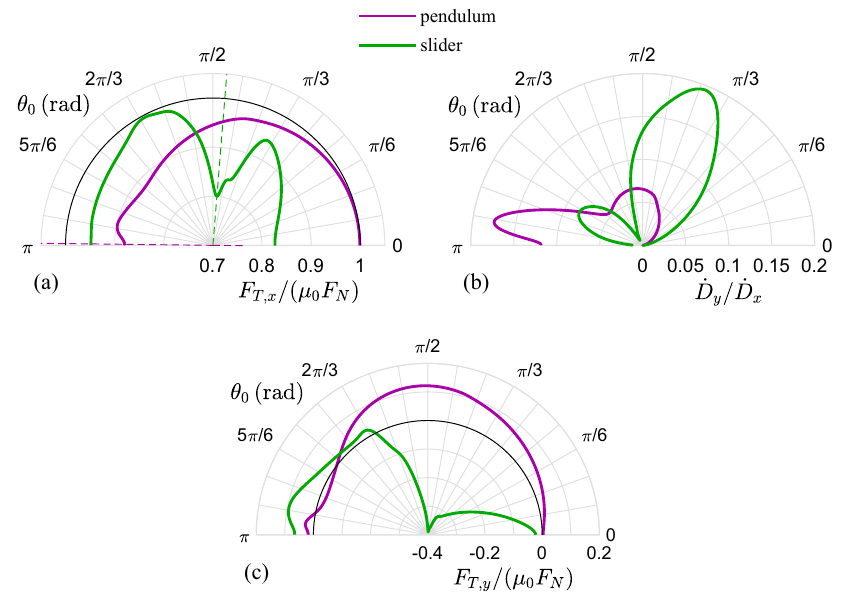
Figure 11. Polar diagrams of ( a ) the normalized apparent friction force F T , x /µ 0 F N , ( b ) the ratio ˙ D y / ˙ D x , ( c ) the normalized apparent friction force F T , y /µ 0 F N as functions of the static orientation angle θ 0 . Two sets of elastic conditions are investigated: pendulum refers to ˜ k r = 3 and ˜ k θ = 0.01 , slider is for ˜ k r = 0.01 and ˜ k θ = 3 . Notably, ˜ F 1 and µ 0 = µ( V 0 ) N =